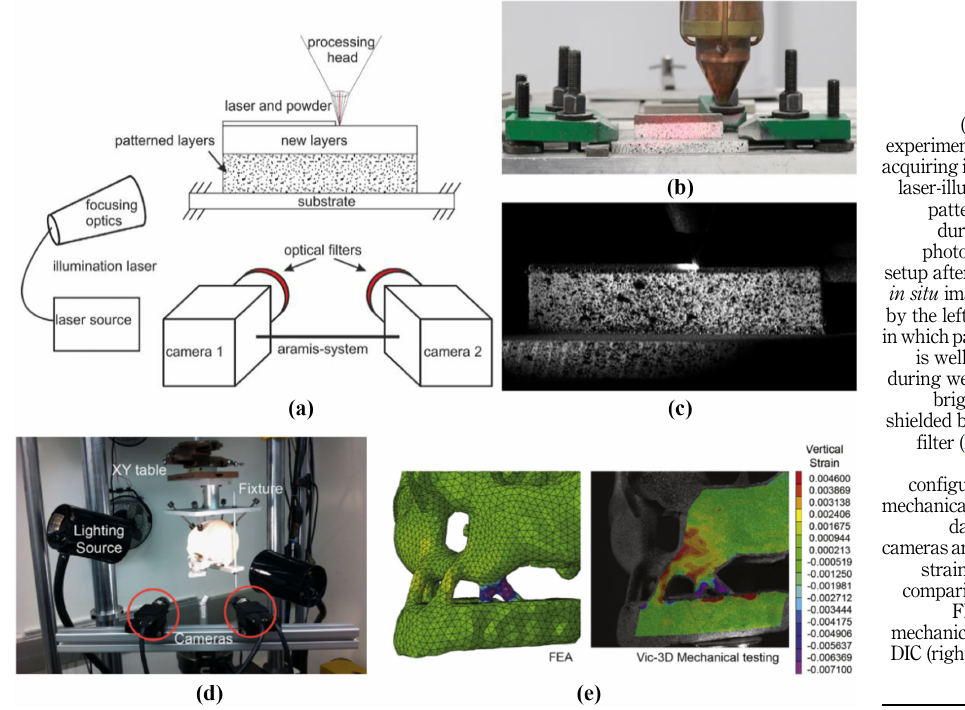
Figure 9. (a) Schematic experimental setup for acquiringimagesofthe laser-illuminated and patterned sample during LMD; (b) photograph of the setup after welding; (c) in situ image acquired by the left DIC camera inwhichpatternedarea is well visible even during welding, as the bright process is shielded by the optical filter (Biegler et al. , 2018); (d) the configuration of the mechanical testing and data-capturing camerasand(e)vertical strain distribution comparison between FEA (left) and mechanical testing by DIC (right) (Sutradhar et al. ,